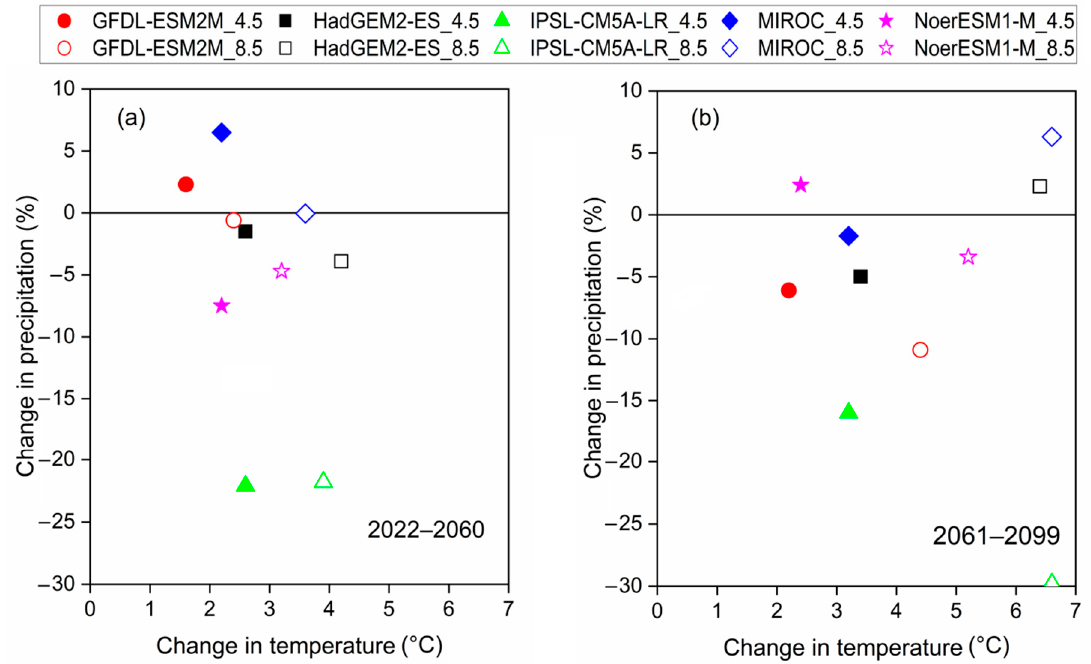
Figure 6. All GCM annual precipitation and temperature changes in the Vakhsh River Basin, Central Asia, under RCPs 4.5 and 8.5 in the ( a ) 2022–2060 and ( b ) 2061–2099 periods, relative to the base period (1966–2004).